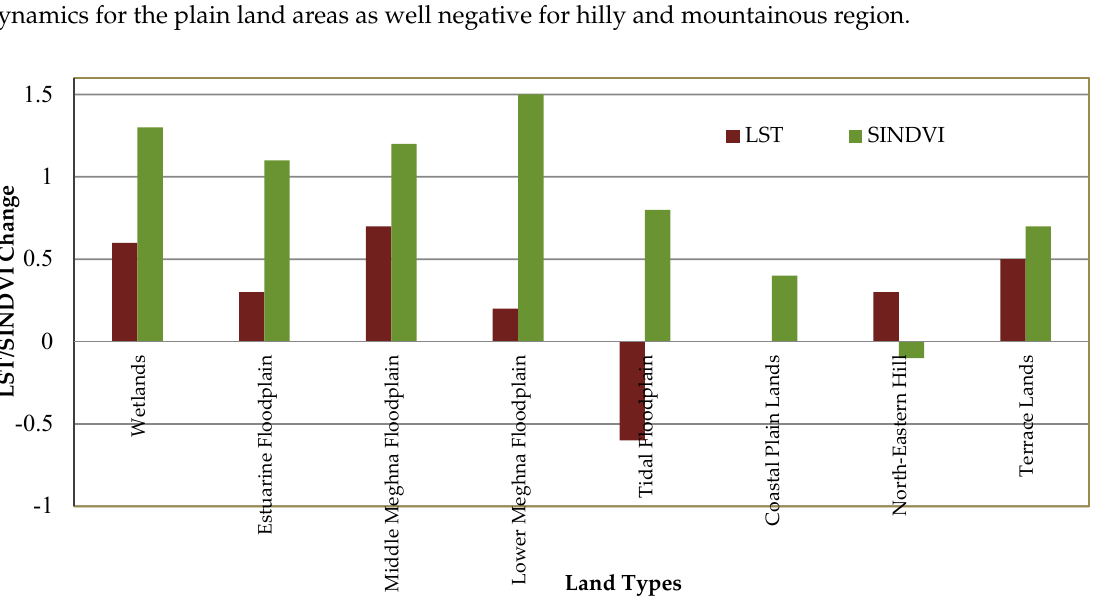
Figure 9. Interannual averages of LST and SINDVI in ( a ) wetlands, ( b ) old Meghna estuarine floodplain,